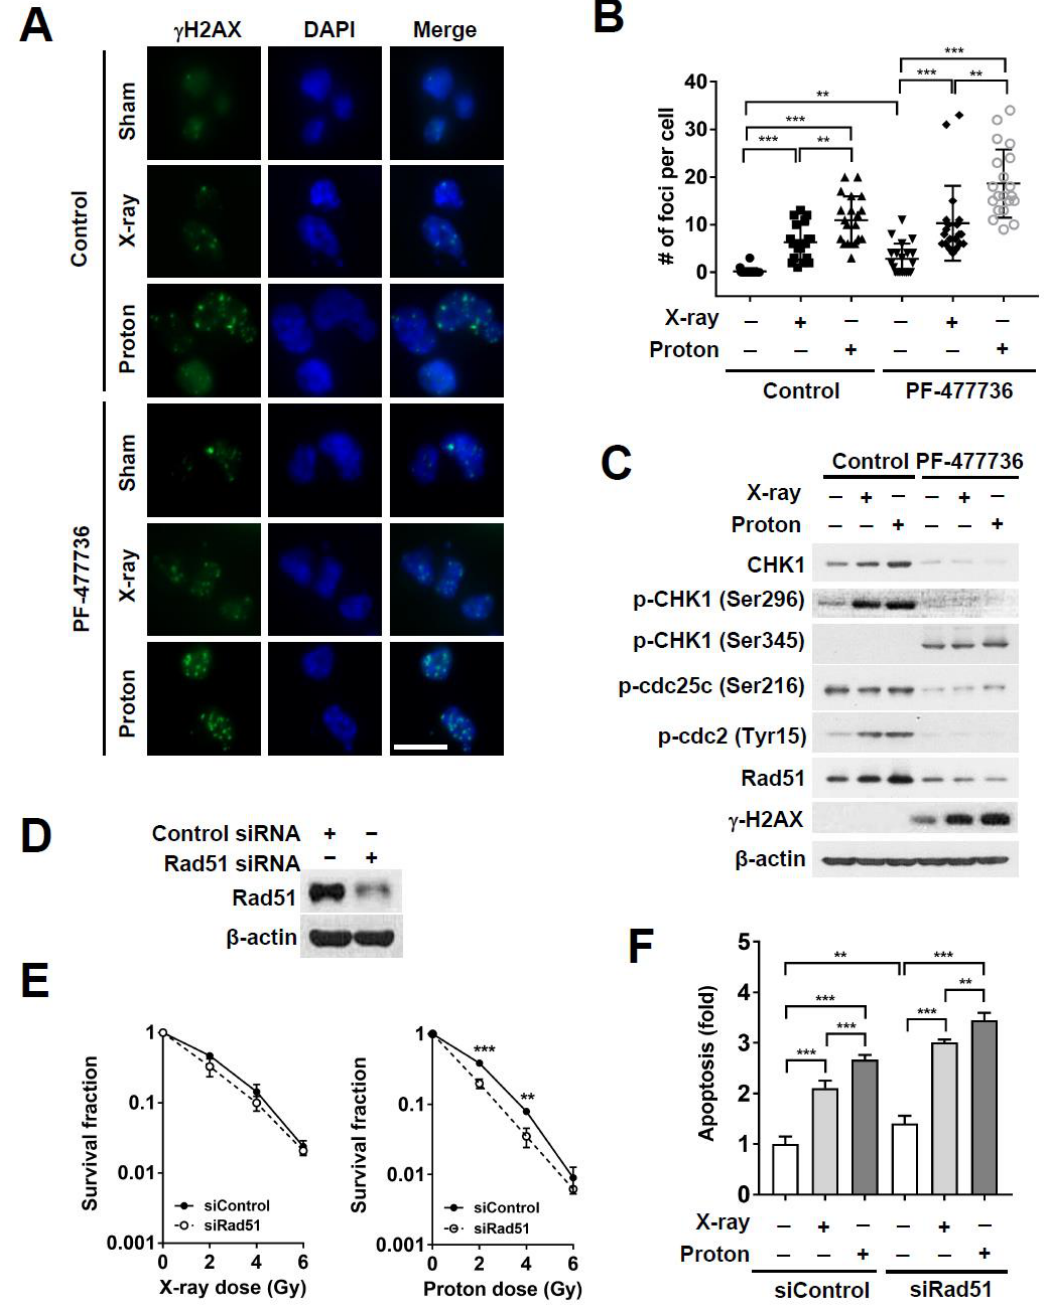
Figure 5. CHK1 inhibition in response to PF-477736 treatment augments proton irradiation-induced DNA damage in MDA-MB-231 cells via Rad51 downregulation. ( A ) Representative immunofluorescence images showing enhanced proton-induced DNA damage upon CHK1 inhibition. MDA-MB-231 cells were pre-treated with 500 nM PF-477736 for 3 h, followed by irradiation with 4 Gy of X-rays or protons. After 24 h of irradiation, cells were fixed and probed using the γ- H2AX antibody (green) and stained with 4 ꞌ , 6-diamidino-2-phenylindole (DAPI) (blue). The scale bar indicates 10 μm; ( B ) Quantification data showing a significant increase in the number of γ-H2AX foci in the nucleus upon pre-treatment with 500 nM PF-477736 for 3 h, followed by irradiation with 4 Gy of protons. Data are shown as mean ± S.D (n = 55) from two independent experiments. ** p < 0.01; ***